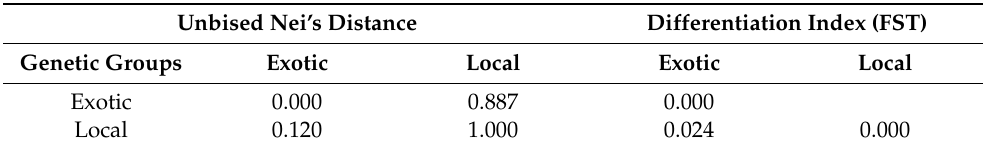
Table 6. Nei’s unbiased measures of genetic identity (above diagonal) and genetic distance (below diagonal) calculated for exotic and local spider plant accessions.